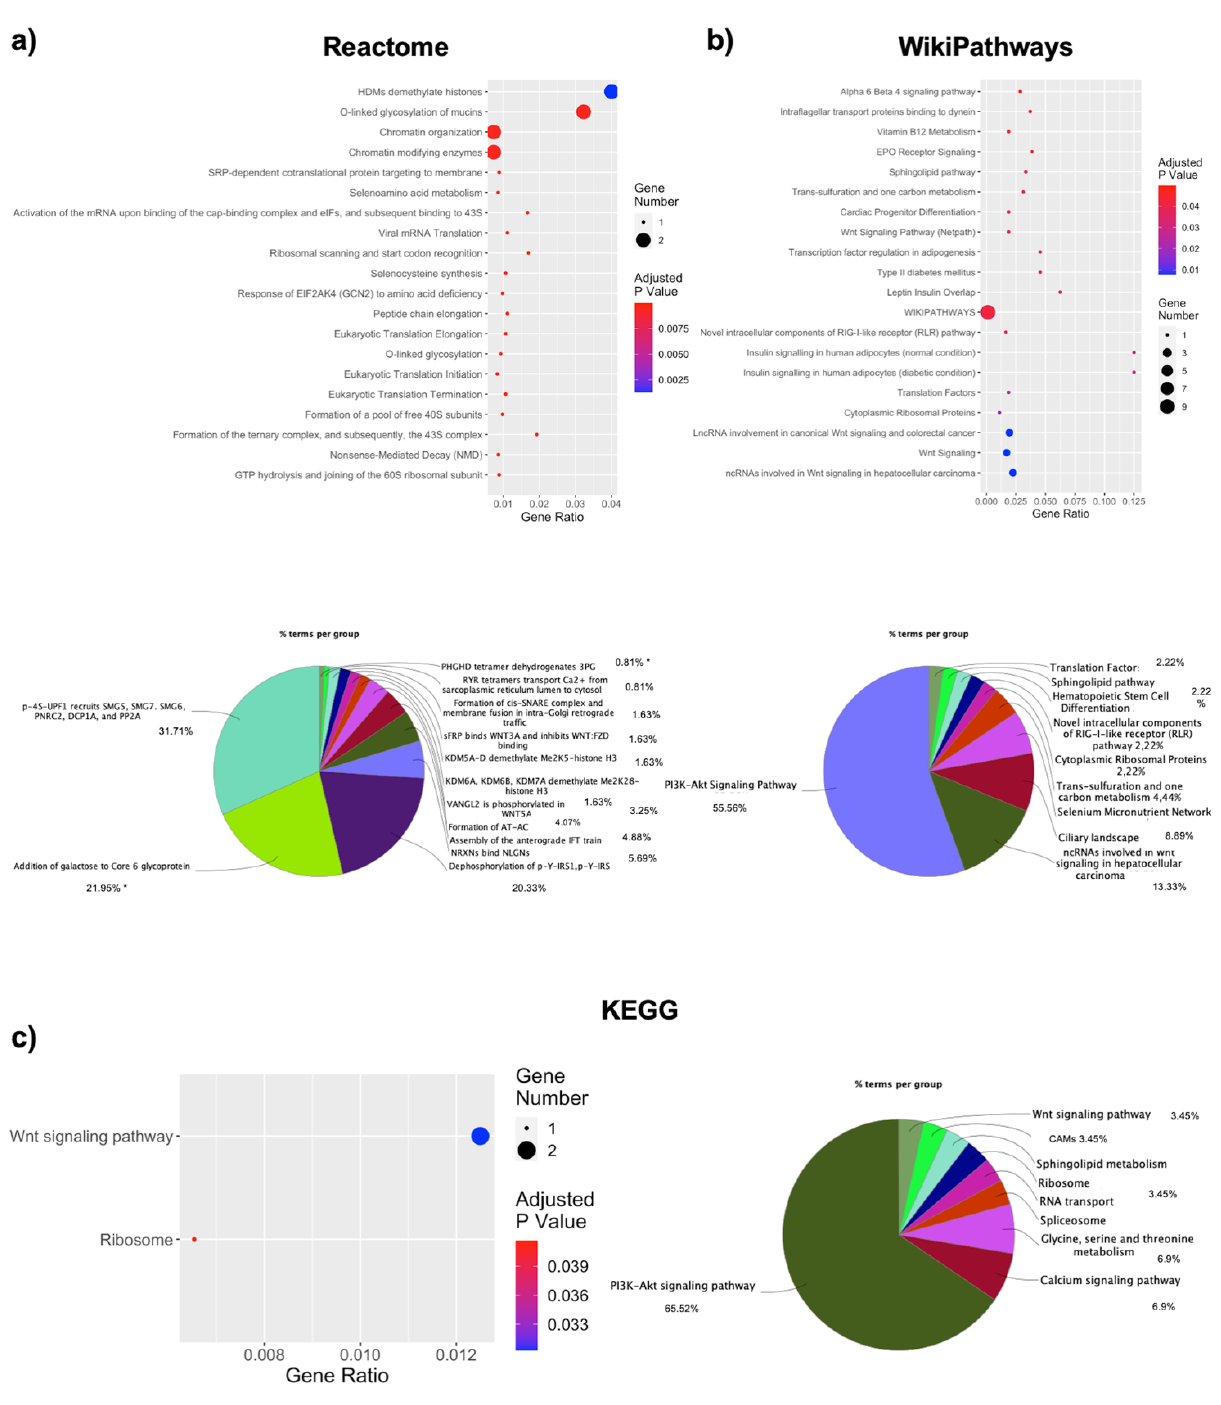
Figure 3. Pathways analysis shows implicated processes in OBM vs OBF. Pathway analysis of significant processes in Reactome ( a ), WikiPathways ( b ), and KEGG database ( c ), represented as dotplot and ClueGO graphs. For dotplots, the y-axis represents the name of the pathway, the x-axis represents the gene ratio, dot size represents the number of different genes, and the color indicates the adjusted p -value. For ClueGO graphs, each pie segment refers to the % of terms present per group and * p < 0.05.